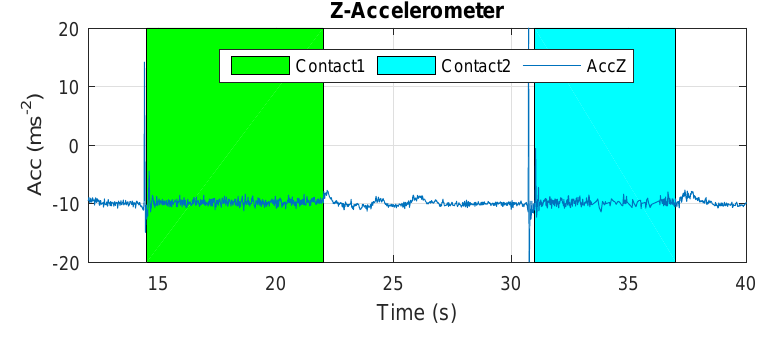
Figure 12. Z-accelerometer—Cartuja bridge experiments.